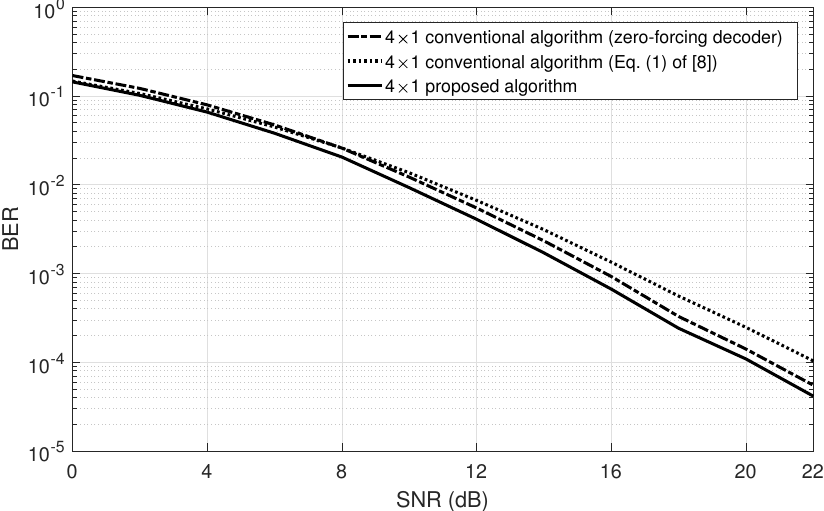
Figure 4. BER performance of the conventional QO-STBC and proposed algorithm as a function of the SNR for the four antennas system in a correlated Rayleigh fading channel (the correlation coefficient =